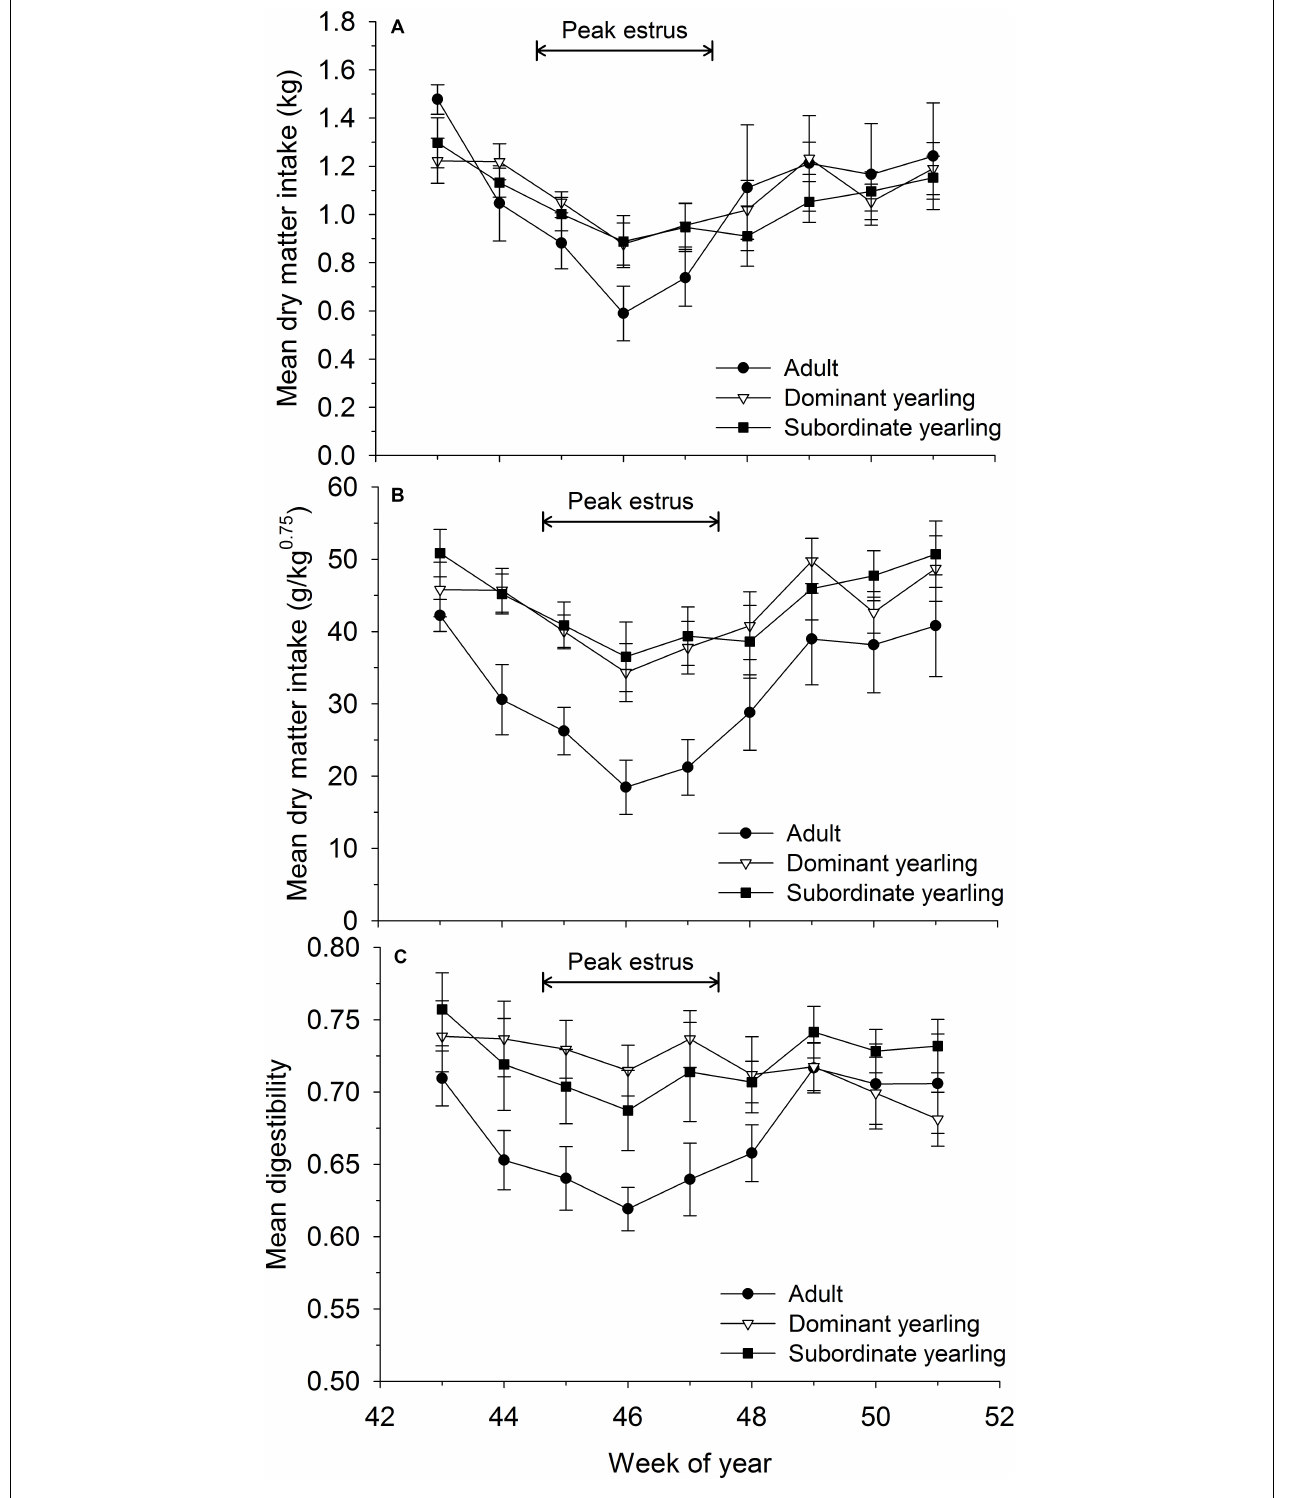
FIGURE 2 | Voluntary feed intake measured weekly as (A) absolute dry matter intake (kg/day ± SE), (B) dry matter intake relative to metabolic body mass (g/kg 0 . 75 /day ± SE), and (C) apparent digestibility (% ± SE) for adult ( ≥ 4.5-years old; n = 12), dominant yearling (1.5-years old in absence of and adult male; n = 11), and subordinate yearling (1.5-years old with adult male present; n = 9) male white-tailed deer during 2006–2008 and 2010–2011, Brookings, SD, United States. Weeks correspond to mid-October through mid-December. Weeks of peak estrus represent dates when 86% of estimated conception events occurred.